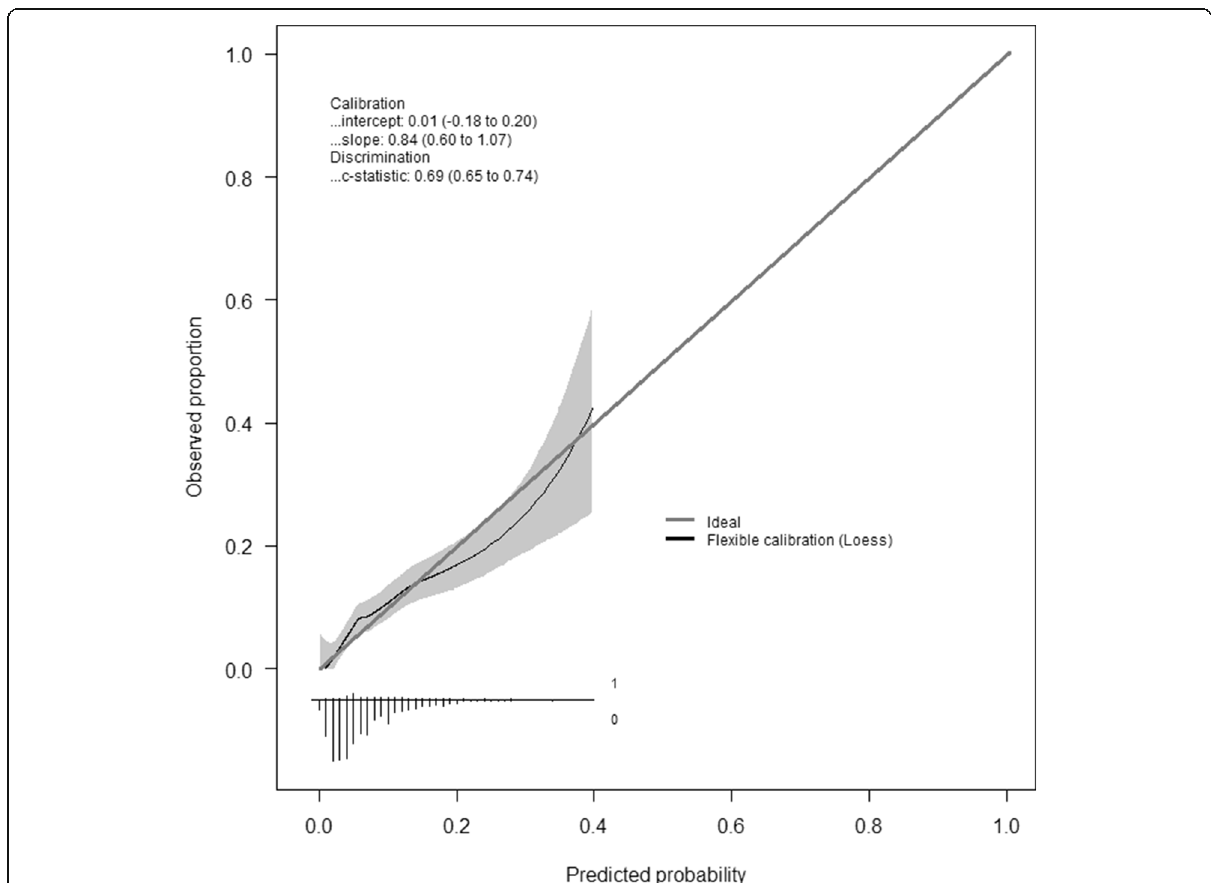
Fig. 2 Flexible calibration curve for the combined external datasets, showing the relationship between the estimated risks (on the x -axis) and the observed proportion of events (on the y